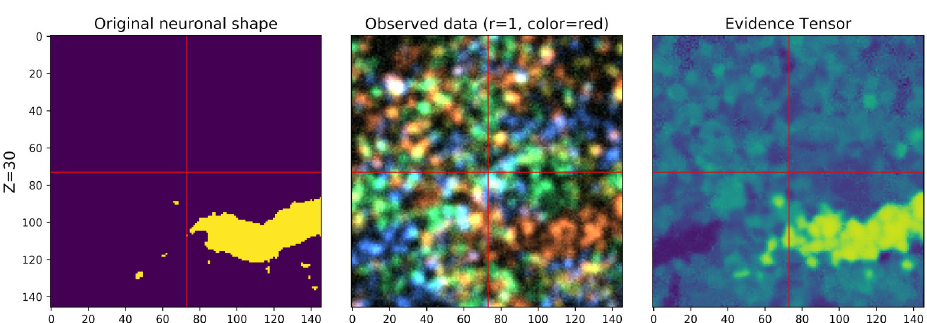
Fig 7. The evidence tensor is used to match barcodes to voxels. The ground-truth morphology at a selected z-plane for an example neuron is shown on the left; an imagestack from one round at the corresponding z-plane ( λ = 10 amplicons/ μ m 3 ) is shown in the middle; on the right, the corresponding z-plane of the evidence tensor for the barcode corresponding to the neuron on the left is shown. Note that the evidence tensor is bright around the locations of the underlying neuron, as desired. A video of this image (across z-planes) can be found at this